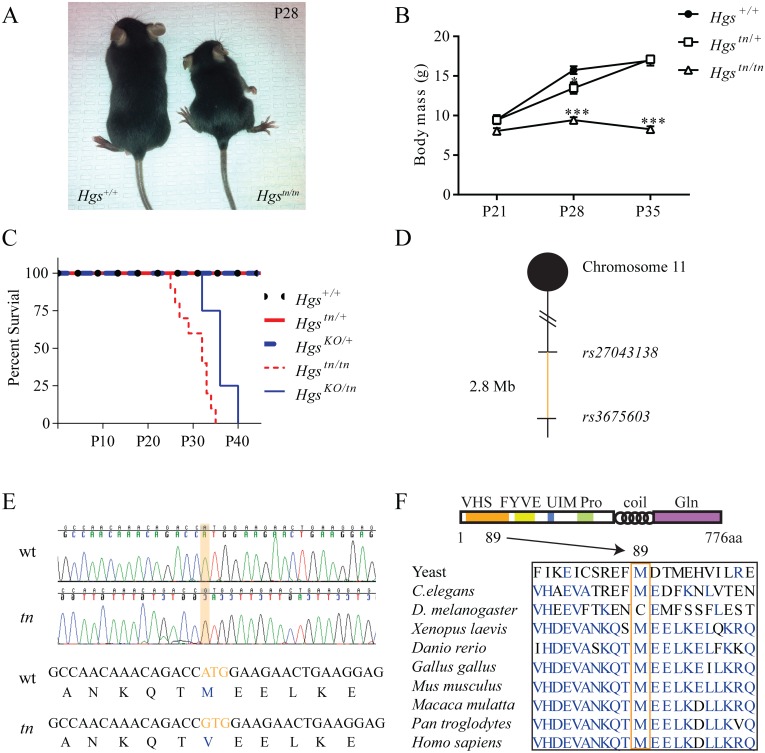
Positional cloning and phenotypic analysis of the tn mice.(A) Image showing reduced size of 4-week-old Hgs
tn/tn mice relative to wild type HGS
+/+ mice. (B) Body mass of 3- to 5-week-old HGS
+/+, heterozygous Hgs
tn/+ and Hgs
tn/tn mice. n > 6 mice per genotype. A two-way anova was used to find a significant effect of genotype on body mass. Symbols represent unpaired t-tests corrected for multiple comparisons using the Holm-Sidak method (C) Kaplan-Meier survival curve of wild type (Hgs
+/+) and Hgs-mutant mice. The Hgs
KO allele does not complement the Hgs
tn allele. A Mantel-Cox test with p<0.001 demonstrated a significant difference between the survival curves of the Hgs
tn/tn and Hrs
KO/tn mice as compared to the Hg
KO/+
Hgs
tn/+, and Hgs
+/+ mice. (D) Meiotic linkage map depicting SNP markers that define the tn critical region. (E) Genomic sequencing of HGS revealed an adenine to guanine change in the Hgs
tn/tn mice, resulting in a methionine to valine substitution at amino acid 89 of HGS. (F) Schematic of HGS protein structure in eukaryotes, demonstrating the conservation of the methionine residue at position 89 in the VHS domain (orange box). Data are shown as mean ± SE. *p < 0.05 and ***p < 0.001.